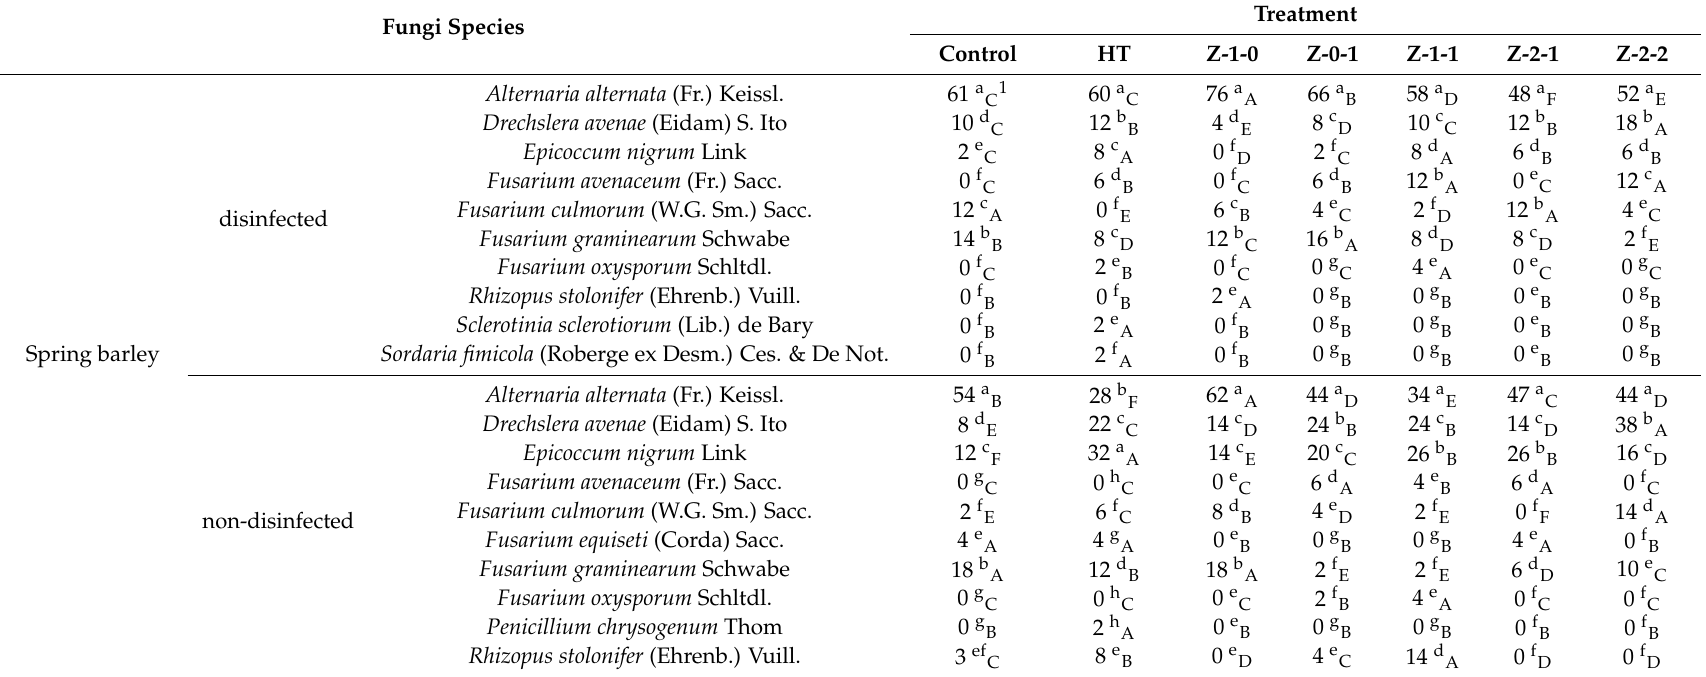
Table A3. The average number of fungi isolated from disinfected and non-disinfected grains of spring barley in 2012 (CFU per 100 grains). Fungi